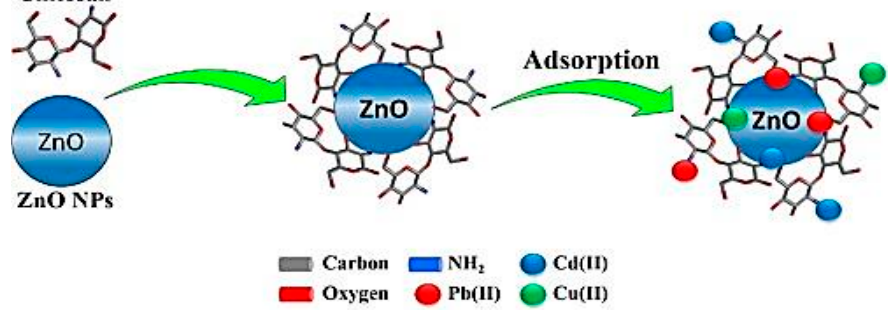
Figure 10. Schematic representation of metal ion adsorption by nanocomposite (Taken from [114]).